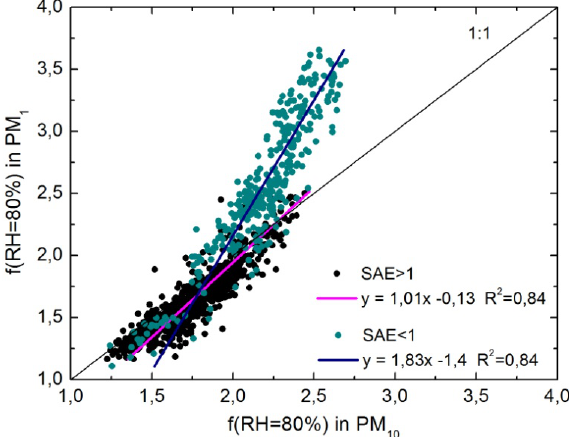
Figure 3. Scatter plot of the hourly average scattering enhancement factors at 80% relative humidity in the PM 1 fraction vs. the same parameter in the PM 10 fraction. Data when the scattering Ångström exponent was below and above 1 were fitted separately.